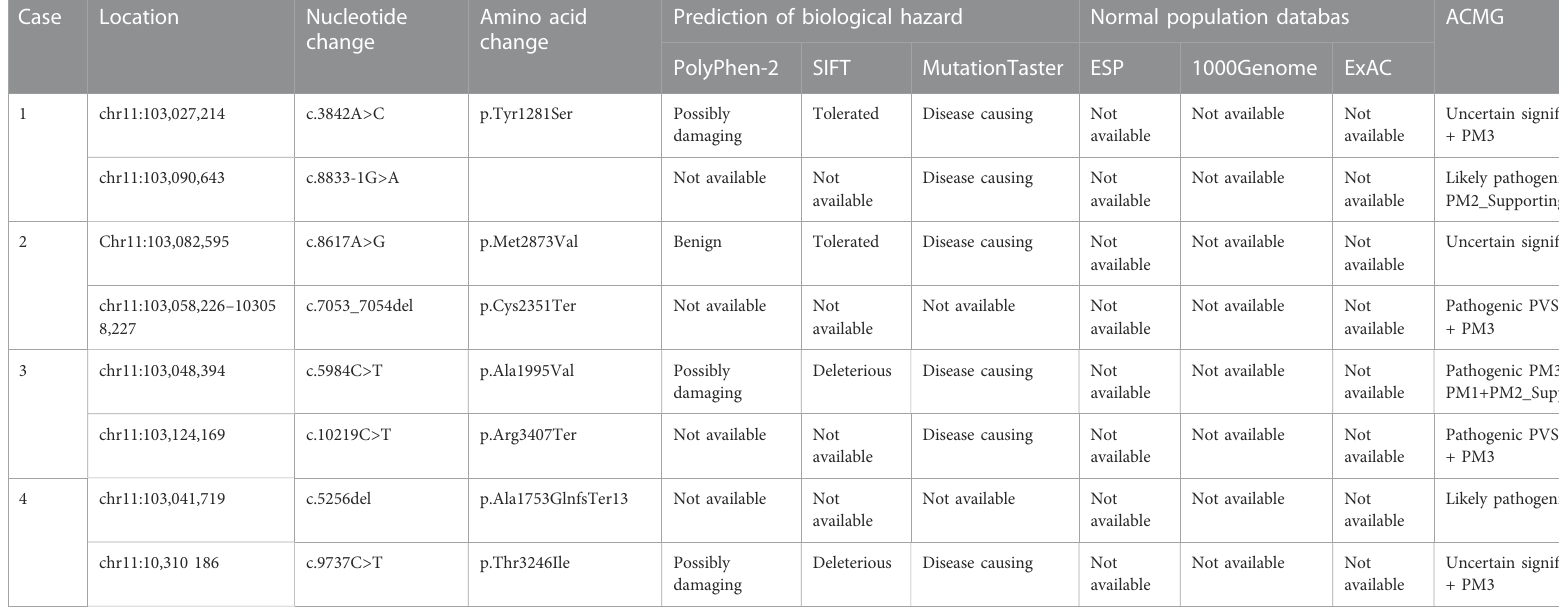
TABLE 2 Pathogenicity analysis of the DYNC2H1 variants and frequency in the normal population.